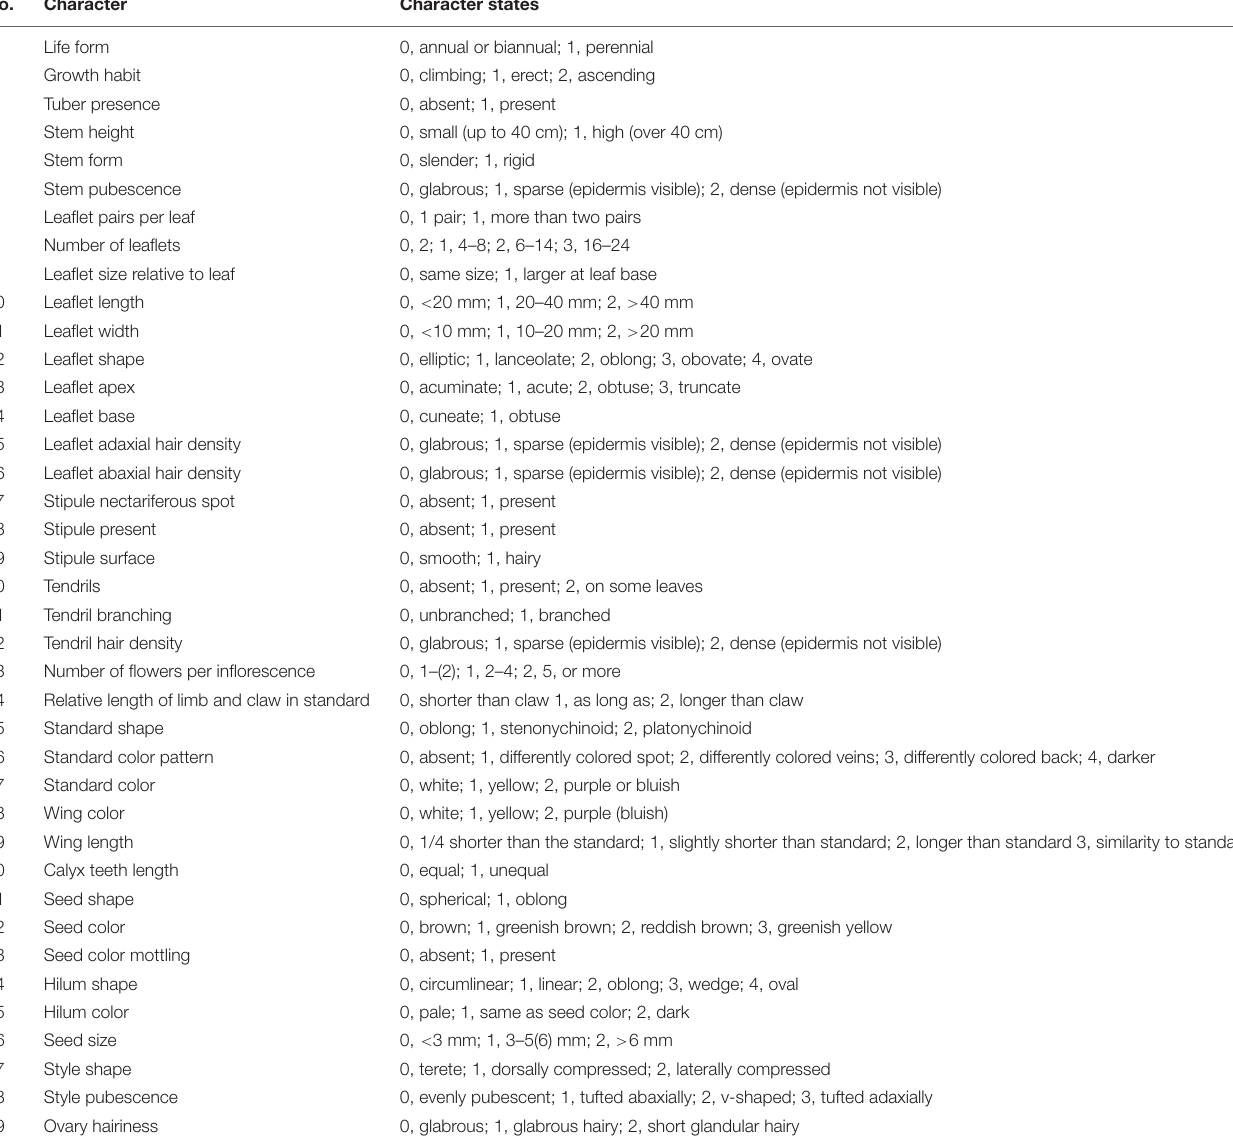
TABLE 2 | List of morphological